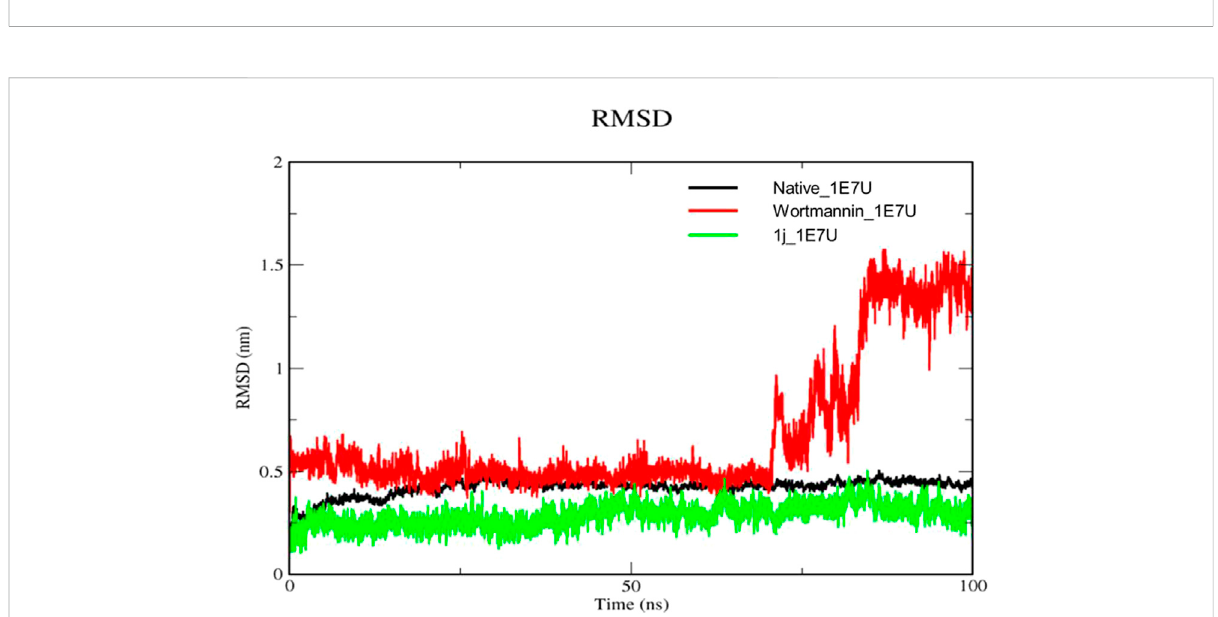
FIGURE 5 RMSD analysis for the native structure of 1E7U (black) and its complex with Wortmannin (red) and 1j (green).